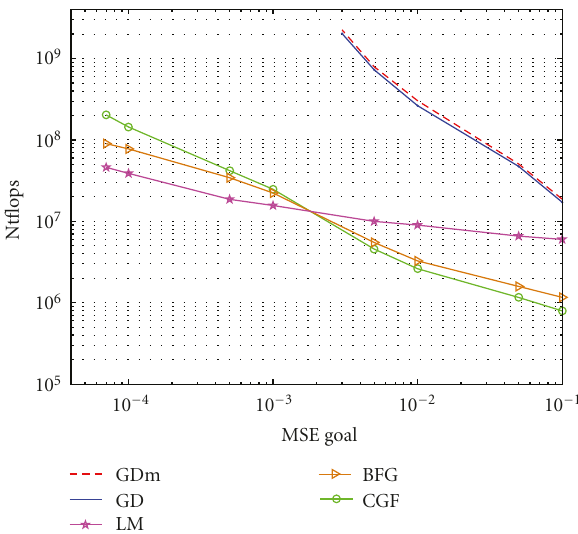
Figure 18: Computation number required versus mean square error.